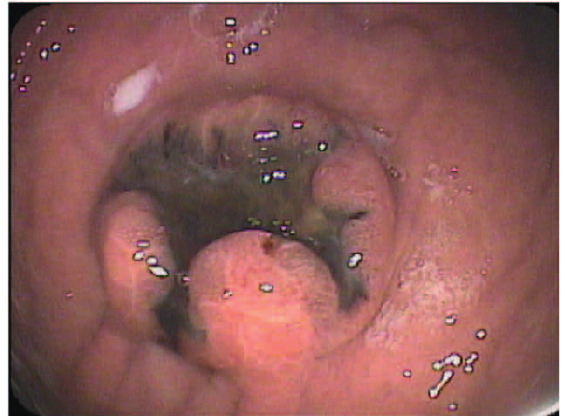
Figure 1. Polipoid melanotic mass with tip ulceration in the stomach